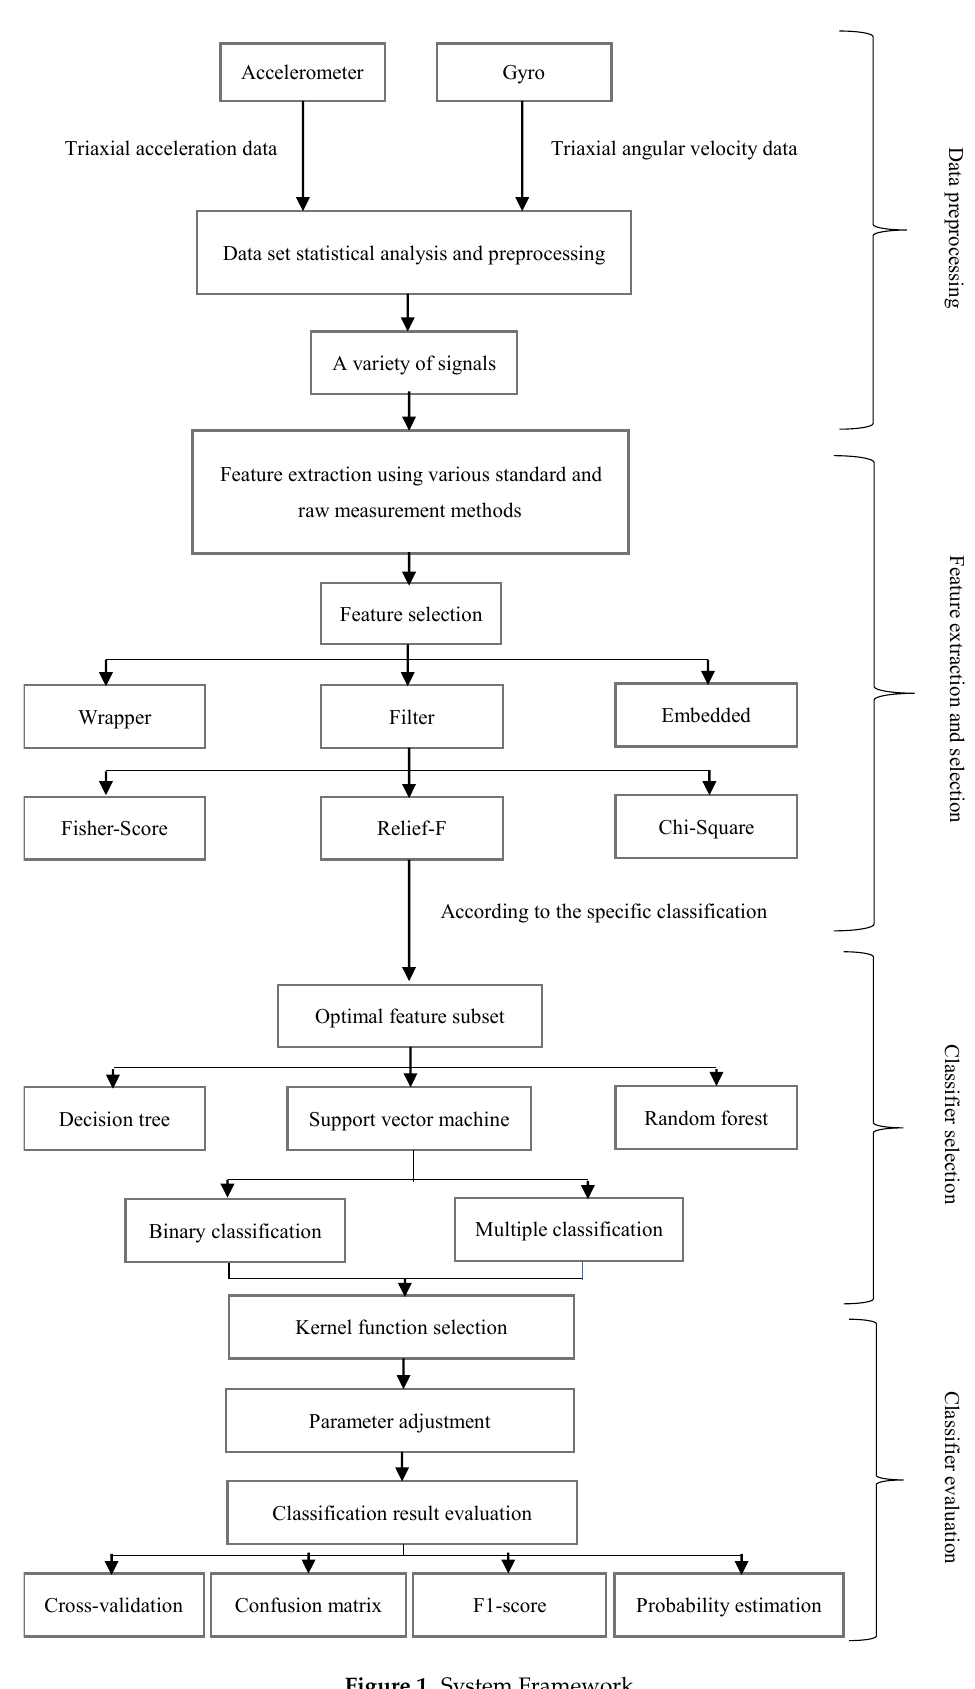
Figure 1. System Framework.